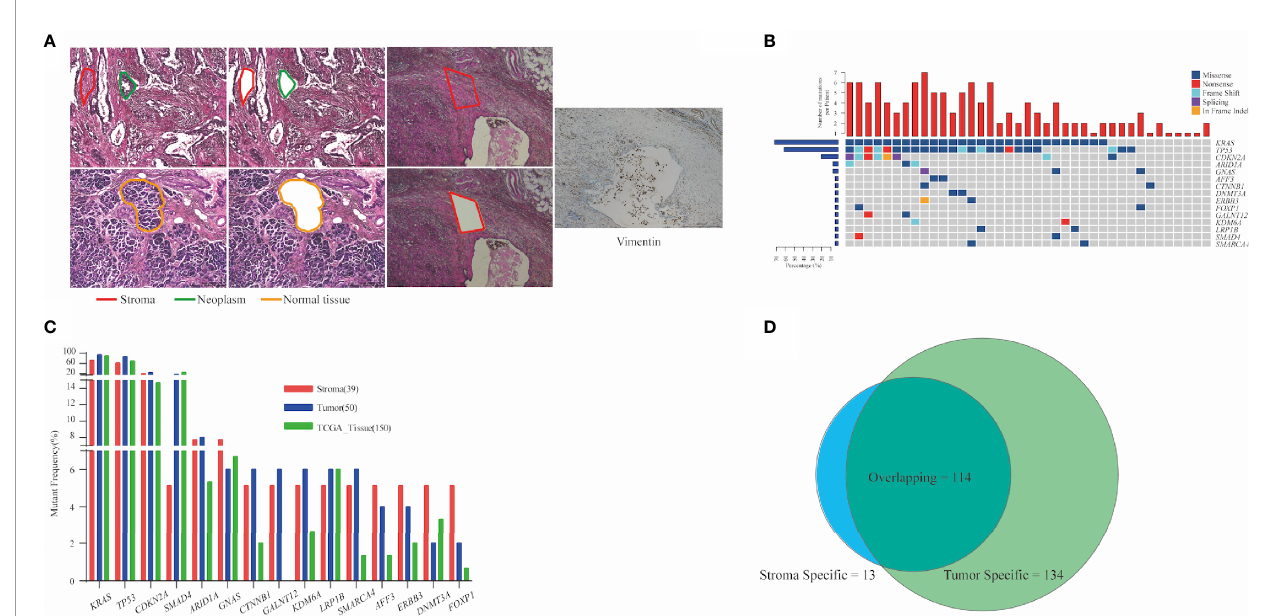
FIGURE 1 | Analysis of mutation detection in stromal components. (A) Representative schematic diagram showing the three components of PDAC: the neoplastic, stroma, and normal pancreatic components. Vimentin was enriched in stromal components. (B) Mutational prevalence of stromal components. Top 15 genes mutated in over two stroma specimens are shown. In total, 127 somatic mutations were detected in stromal components from 39 patients. KRAS (71.8%), TP53 (61.5%), and CDKN2A (23.1%) were the most recurrent mutant genes. Top bars indicate the number of mutations. Left-hand bars represent the frequency of each gene. Hot plot shows the detailed mutations detected in each patient. (C) Comparison of mutant frequencies of top 15 genes in stroma, tumor, and public TCGA database. Altered KRAS and TP53 were the most commonly altered genes and demonstrated concordance in three cohorts. (D) Common mutations in stromal and matched neoplastic components; 89.8% mutations in stroma also co-existed in matched neoplastic components. Thirteen stromal mutations were absent in matched neoplastic components, while 134 mutations were exclusive to the neoplastic components. PDAC, pancreatic ductal adenocarcinoma; TCGA, The Cancer Genome